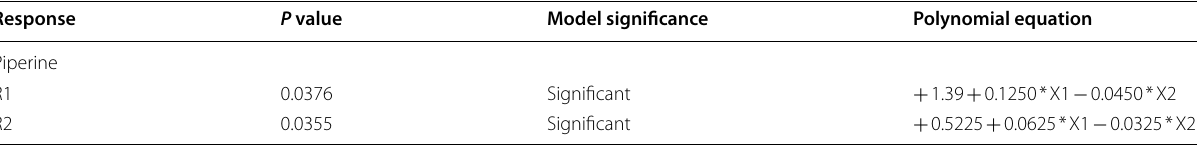
X1 and X2 are independent variables where, X1—conc. of acetic acid in aqueous phase and X2—mobile phase ratio